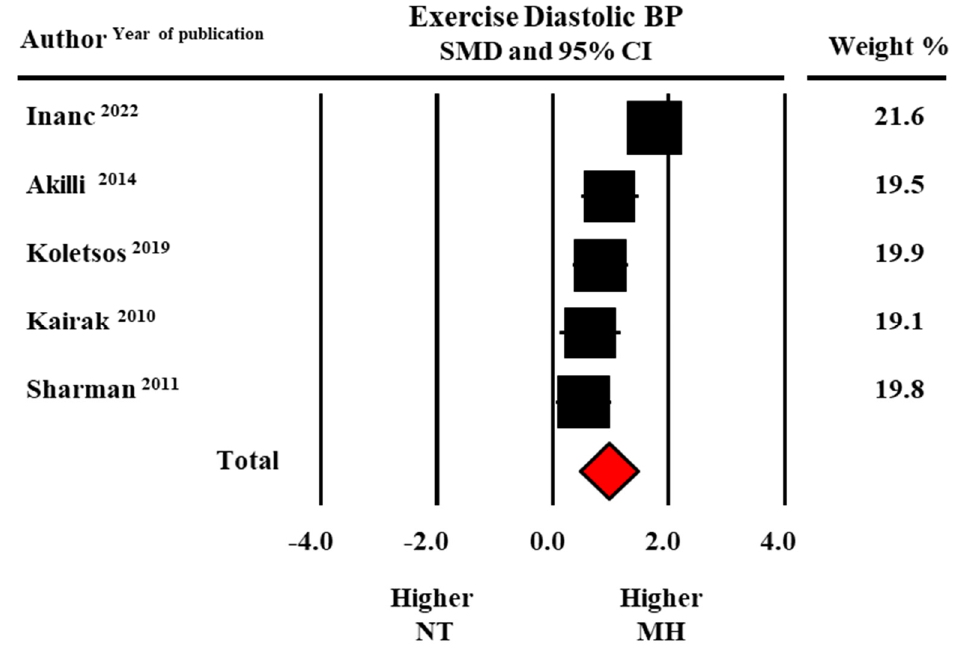
Figure 5. Forest plot of diastolic blood pressure (BP) at peak exercise in masked hypertensive (MH) and normotensive (NT) individuals. Standard mean difference (SMD) and 95% confidence interval (CI). Fixed model [22–24,28,29].